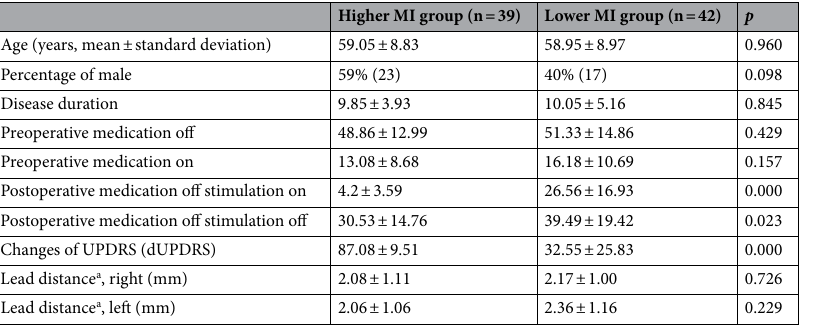
Table 2. Comparison of characteristics between the higher and lower MI groups. Values reported as mean ± standard deviation. MI, motor improvement. a The shortest distance between targeted coordinates and the measured coordinates of the active